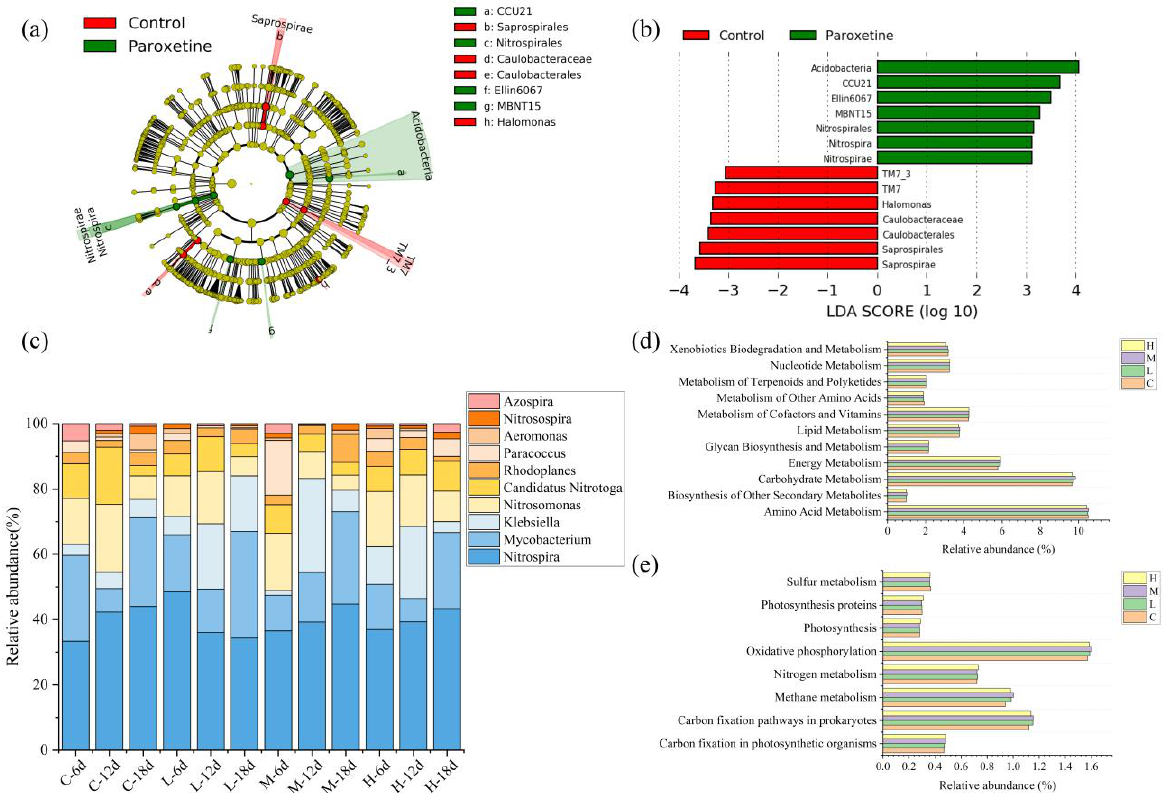
Figure 3. Bacterial taxa with significant abundance differences between control and paroxetine groups and the relative abundance of nitrogen-transforming bacteria and predicted functional profiles in different treatment groups. ( a ) is the cladogram of bacterial communities. ( b ) is LDA score identified the size of differentiation between the control and paroxetine groups with a threshold value of 3.0. ( c ) is the relative of nitrogen-transforming bacteria in different treatment groups. ( d ) is the relative abundance of metabolism in KEGG categories (level 2). ( e ) is the relative abundance of energy metabolism in KEGG categories (level 3). C: the sediment with no paroxetine added; L: 10 μg/L paroxetine; M: 100 μg/L paroxetine; H: 1000 μg/L parox etine.